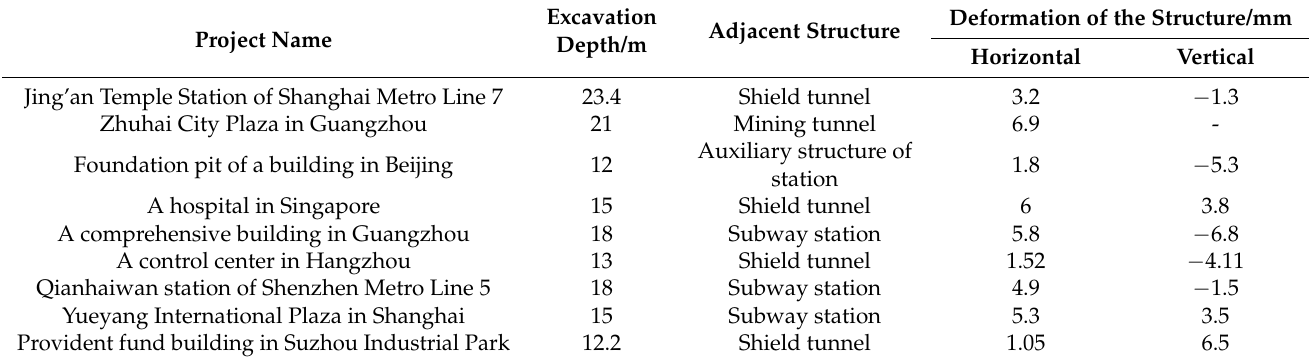
Table 1. Cases of adjacent foundation pit engineering.